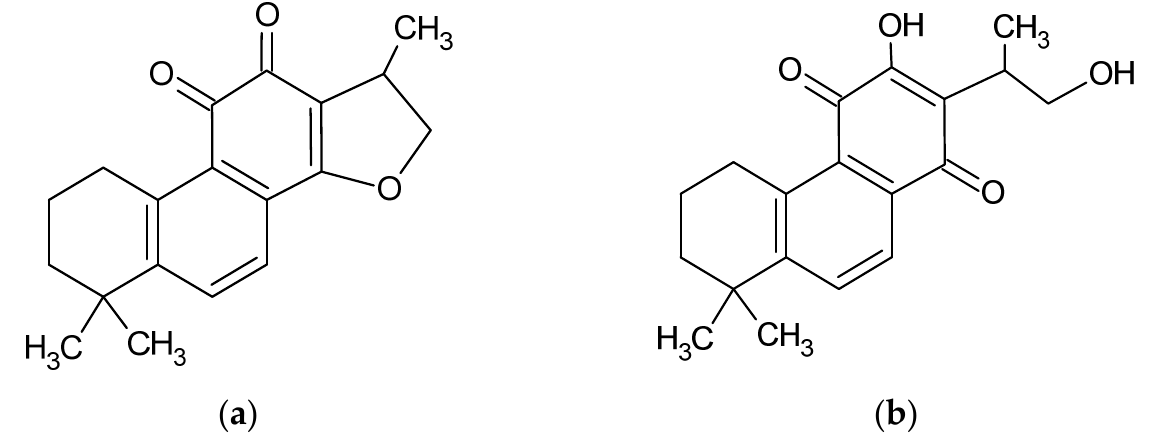
Figure 1. Chemical structure of cryptotanshinone (1,2,6,7,8,9-hexahydro-1,6,6-trimethyl-(R)-fenanth [1,2-b] furan-10,11- dione) ( a ) [4] and its enol form ( b ) [28].